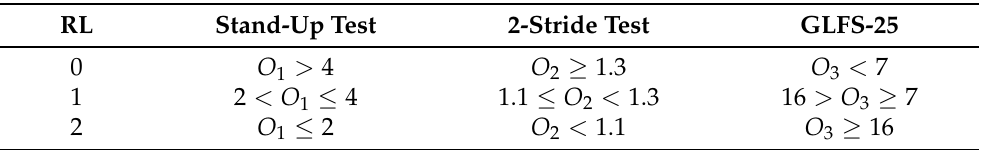
Table 5. Using the Short Test Battery Locomotive Syndrome (STBLS) test parameters to determine the Risk Level (RL) in individuals. The STBLS test includes stand-up, 2-stride, and Geriatric Locomotive Function Scale (GLFS-25) scores